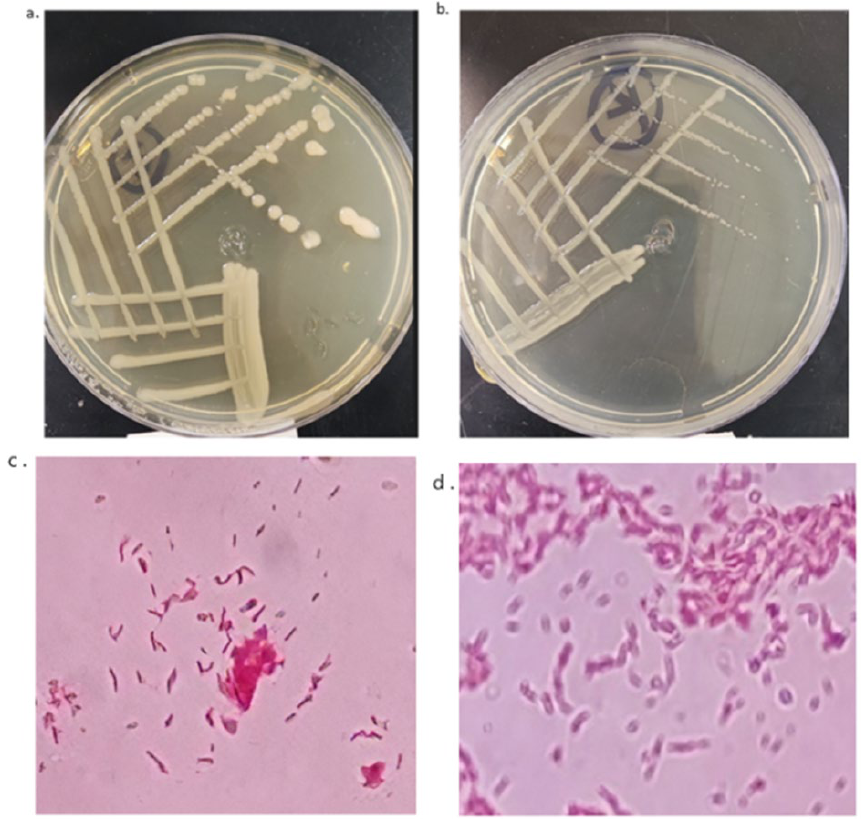
Figure 1. Bacterial colonies of APCZ14: ( a ) APCK5, ( b ) on nutrient agar plates, ( c ) APCZ14 under microscope, and ( d ) APCK5 under microscope.